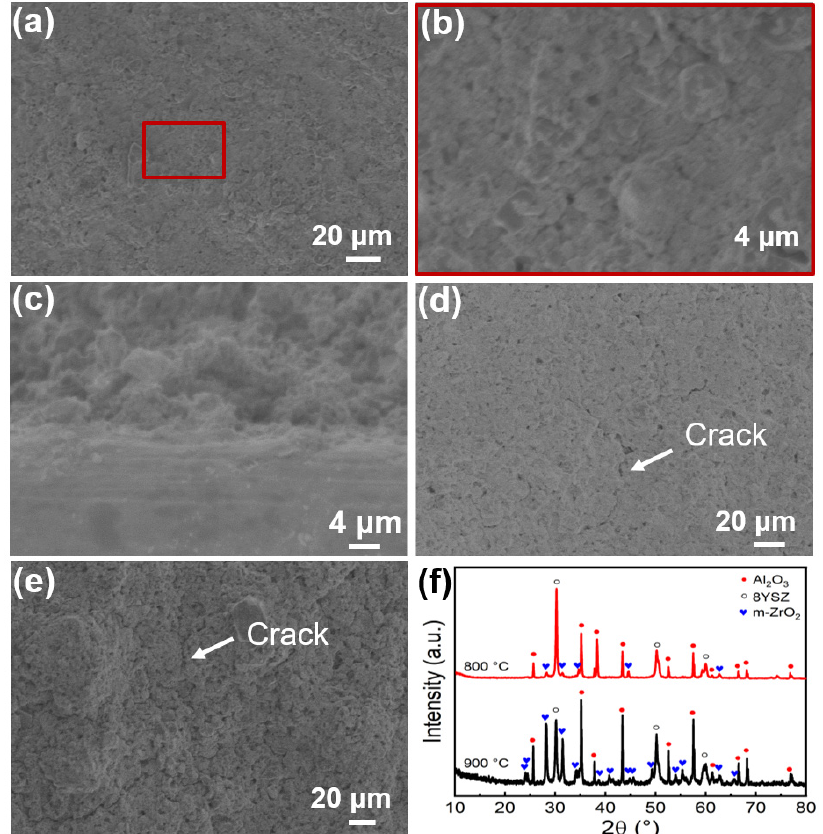
Figure 7. SEM images of the SiOC/Al 2 O 3 /YSZ coatings after thermal shock test: ( a – c ) after 6 cycles during 800 °C-RT: ( a ) and ( b ) surface-section, ( c ) cross-section; ( d ) after 7 cycles during 800 °C-RT; ( e ) after 1 cycle during 900 °C-RT; and ( f ) XRD patterns of SiOC/Al 2 O 3 /YSZ coatings after thermal shock test during 800 °C-RT and 900 °C-RT after 6 cycles.